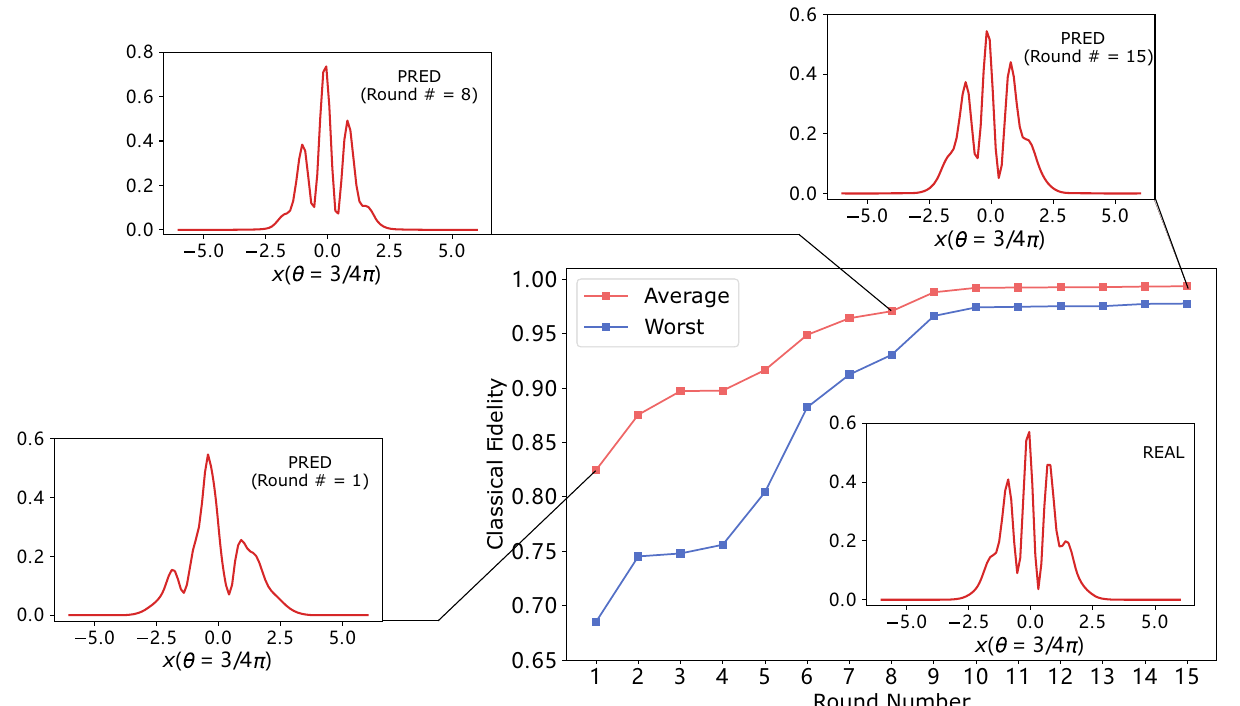
Fig. 3 | Online learning of cat states in 15 time steps. Each red point shows the classical fi delity,averagedoverallthepossiblemeasurementsin M andoverallthe cat states in the test set, which we take to bethe same as in the experiments in the previoussection.Eachbluepointistheworst-caseclassical fi delityoverallpossible